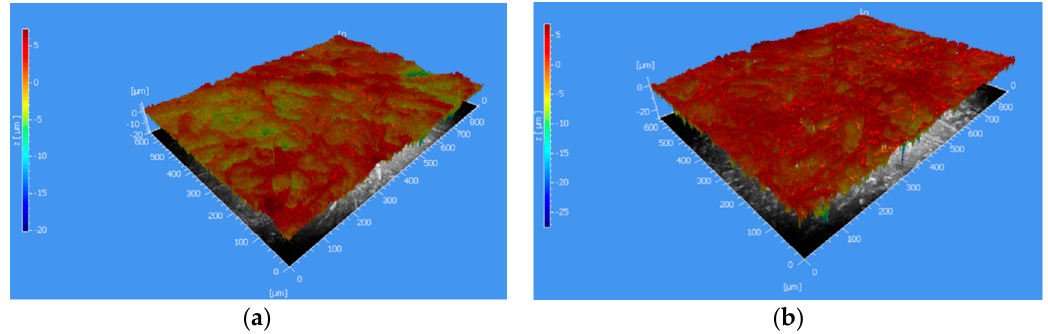
Figure 3. 3-D white-light interferometry (WLI) mapping of the substrate surface of ( a ) type 4 and ( b ) type 7 over an area of 800 × 660 µm.